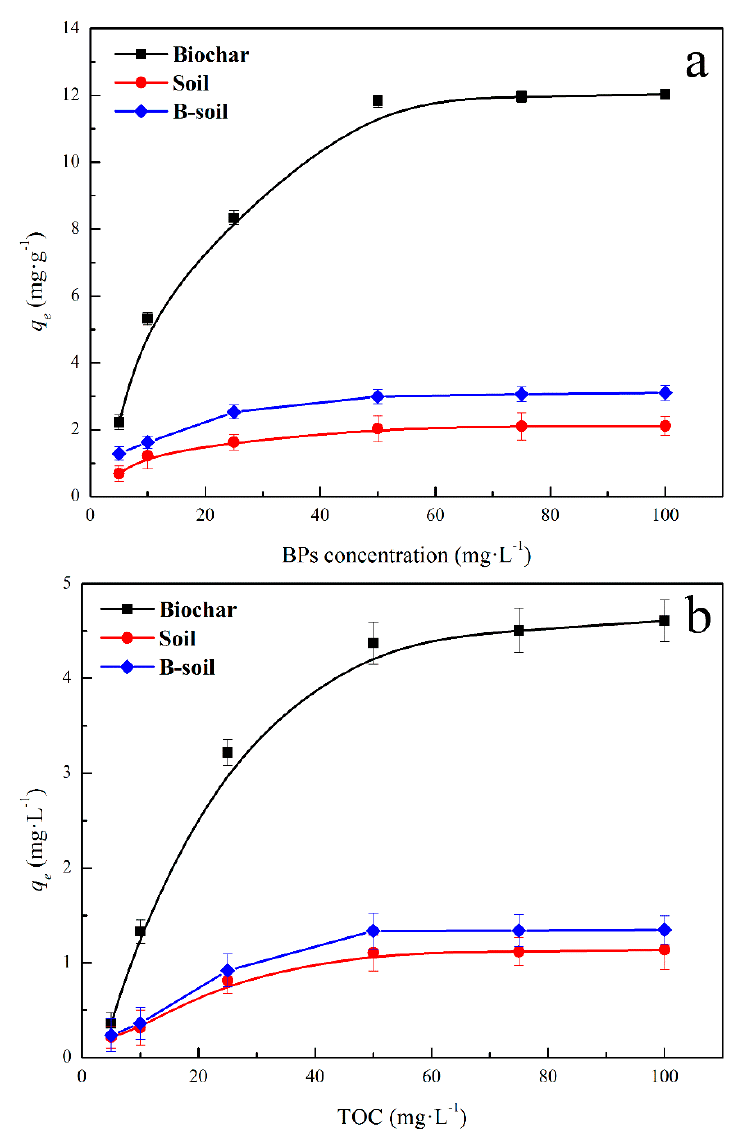
Figure 3. BPs ( a ) and DOM ( b ) equilibrium adsorption amount on the samples.